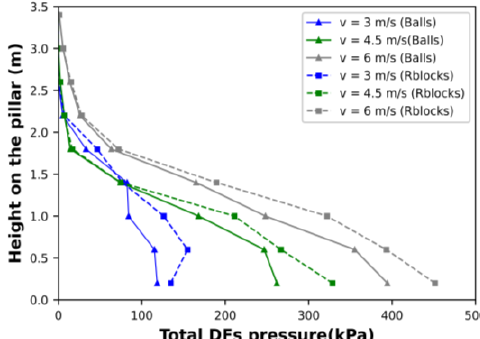
Fig. 8.: Total stress induced by DFs versus the flow height on the pillar for three cases of flow velocity (dashed curve presents the results of